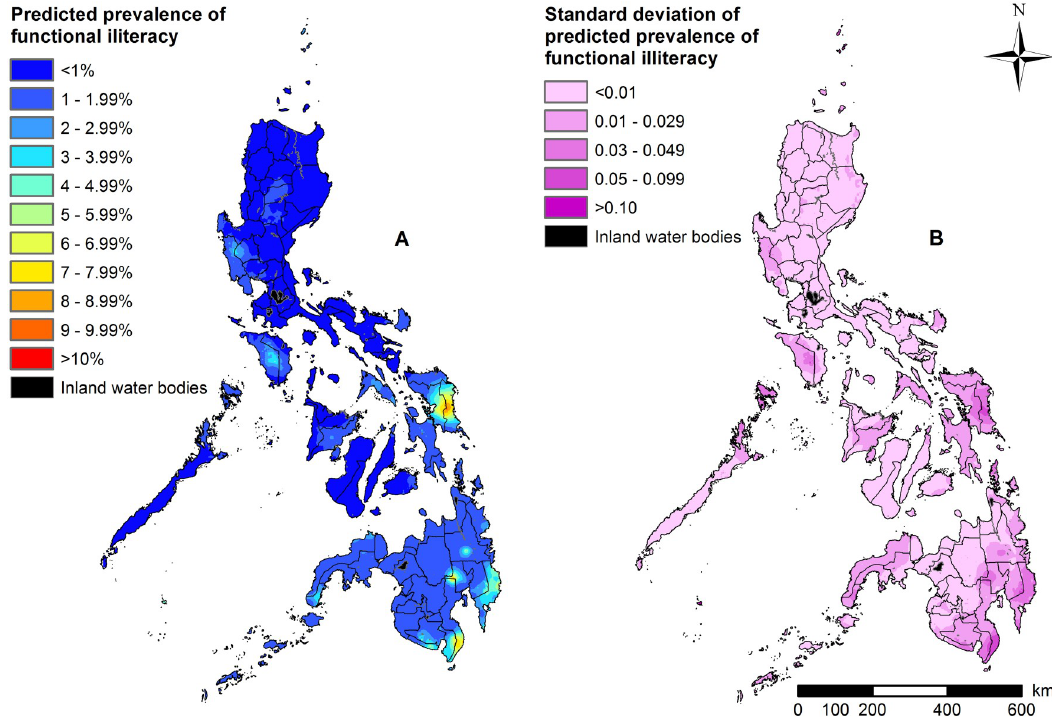
Fig 1. Maps of functional illiteracy in the Philippines. (A) Predicted prevalence. (B) Standard deviation of predicted prevalence. Note: Results based on Model 3 for Luzon and the Visayas; based on Model 5 for Mindanao.